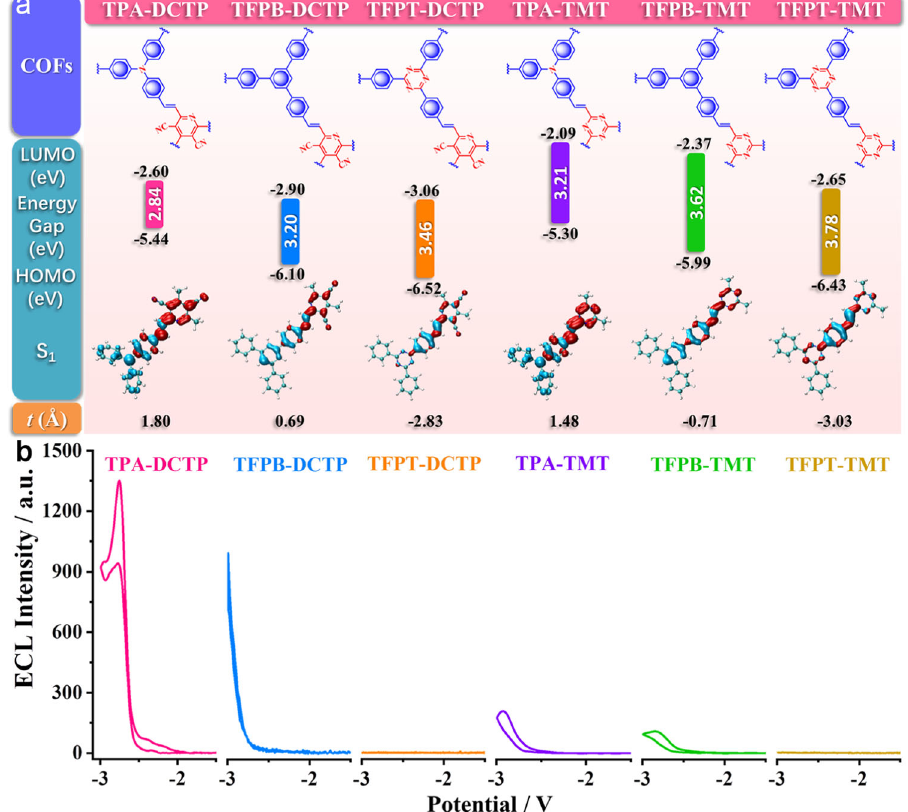
Fig. 3 In fl uence of D-A in COFs on ECL performance. a DFT calculations to the building blocks of COFs. The values of HOMOs, LUMOs, and calculated energy gaps and analysis for the distribution of hole (blue) and electron (red) for S 1 are indicated. The t index is measured to evaluate the separation degree of hole and electron. b Comparison of ECL intensities of COFs in 0.1 M PBS with 0.1 M KCl between 0 V and − 3.0 V. PMT: 800 V, pH 7.5, potential scan rate: 100 mV s − 1